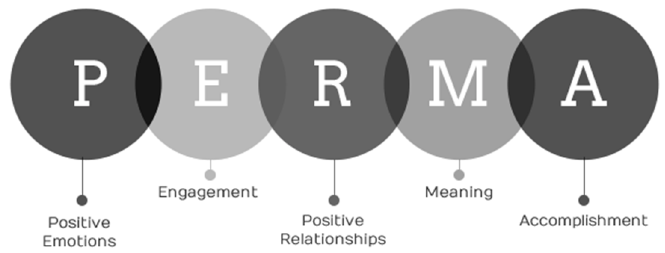
Figure 1. The positive psychology PERMA model.